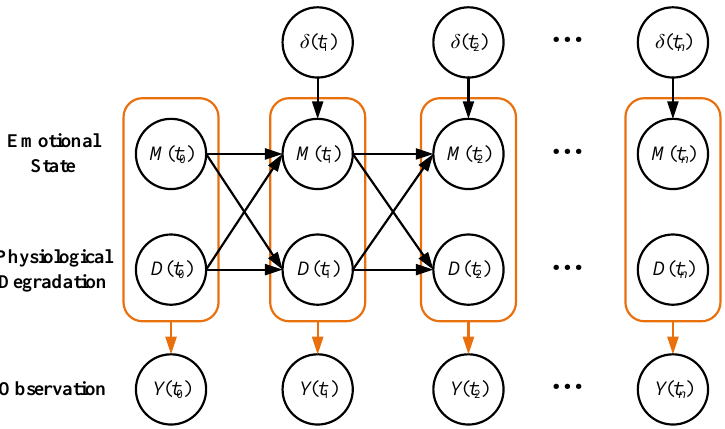
Figure 2. A novel coupling model of physiological degradation and emotional